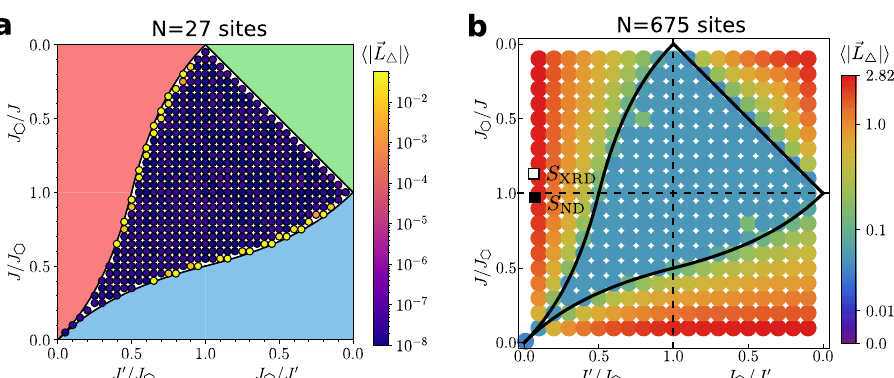
! Fig. 4 Local ground state constraint within the classical spin liquid phase. a Value of hj L 4 ji (averaged over triangles) in the optimal classical ground state found by iterative minimization. The results are obtained in the classical spin liquid phase on an N = 27 sites cluster (see ! ! Supplementary Fig. 1). Most of the points ful fi ll the L 4 ¼ 0 constraint for the ground state. The small number of points with hj L 4 ji > 0 are ! ¼ ð 1 = 3 ; 1 = 3 Þ order. b Phase diagram from found to have a coplanar non-degenerate ground state which corresponds to the nearby Q ! classical Monte Carlo simulations. We depict the average of j L 4 j for 10 simulated systems with N = 675 sites (type-II cluster, L = 5, cf. ! ! ¼ ð 1 = 3 ; 1 = 3 Þ ( Q ¼ 0 ) ordered phase, with Supplementary Note 1) at the temperature T ¼ 0 : 001 J max , where J max ¼ max ð J ⬡ ; J ; J 0 Þ . The Q ! maximal spin susceptibility at the K 0 or K 0 ( Γ ) points in the Brillouin zone, lies outside the region de fi ned by Eqs. (5) where L 4 can never be 2 3 ! ! zero. Inside the region where L 4 can potentially vanish, we still fi nd fi nite but small values. The maximum value in the plot, hj L 4 ji max ’ 2 : 83 , is found at the points of maximal distortion, i.e., J 0 ð J Þ ¼ 10 J ⬡ ¼ 100 J ð J 0 Þ . The logarithmic color function scales